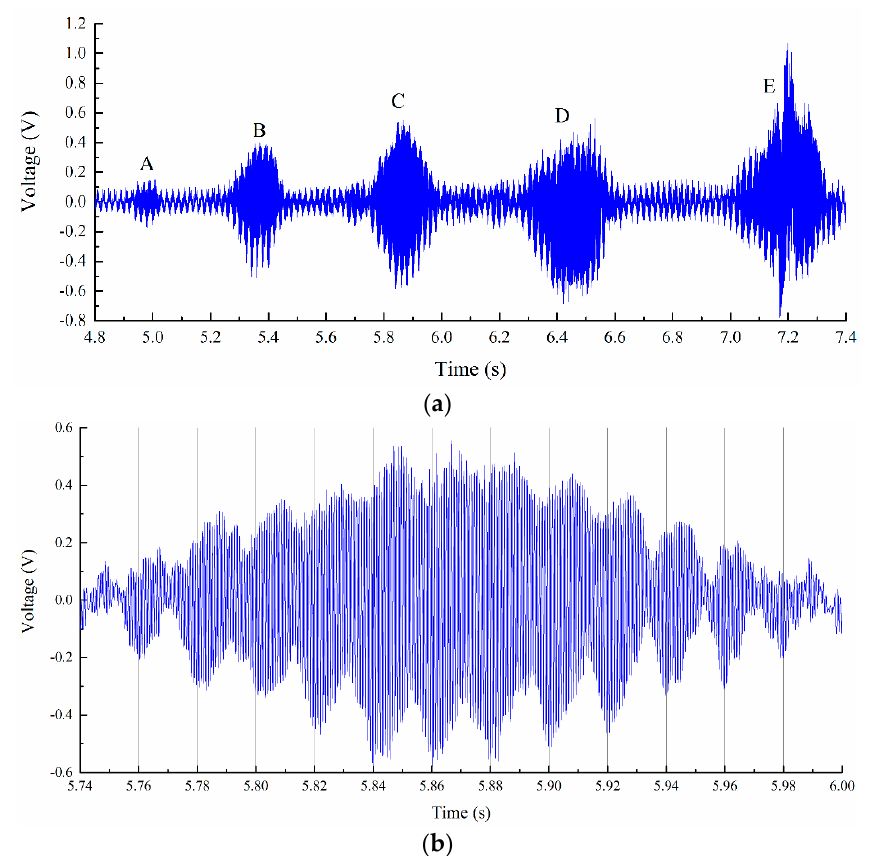
Figure 11. Vibration stage. ( a ) Workpiece vibration; and ( b ) enlarged view of workpiece vibration signals at position C.